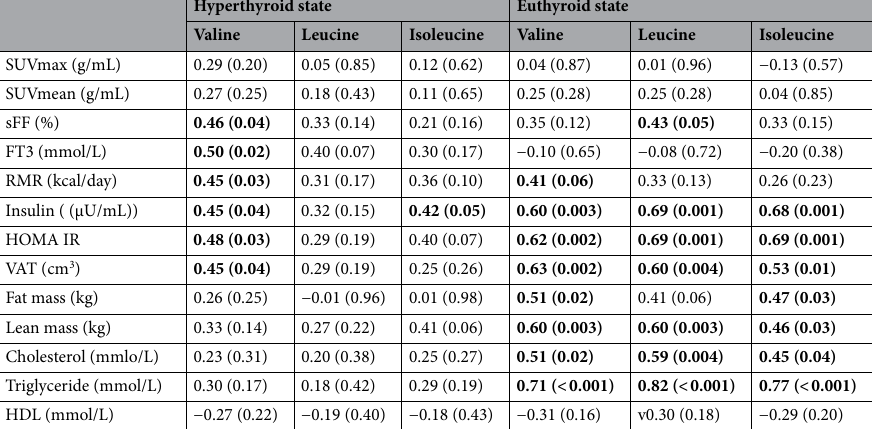
Table 6. Correlations between BCAA concentration at hyperthyroid and euthyroid state with metabolic parameters at both state. N = 22 except for SUV max, SUV mean, sFF and VAT data (N = 21). Correlations were used to assess relationship between variables. Valine, leucine and isoleucine at hyperthyroid state correlations with metabolic parameters at hyperthyroid state. Valine, leucine and isoleucine at euthyroid state correlations with metabolic parameters at euthyroid state. Significant correlations between variables are shown in bold with corresponding coefficient (r) and P values. SUVmax standardized uptake value maximum,